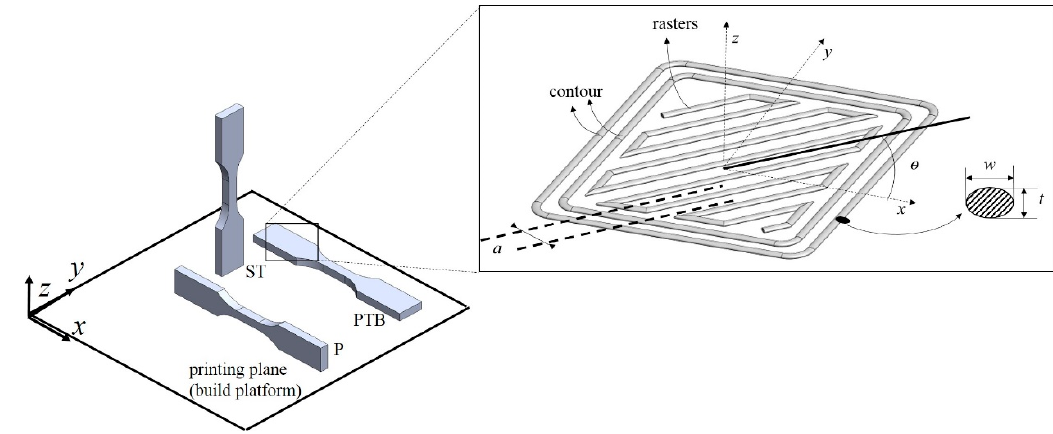
Figure 4. Main structural parameters studied in the mechanical characterization, including the print orientations, raster angle, number of contours, and rasters cross-section. orientations, raster angle, number of contours, and rasters